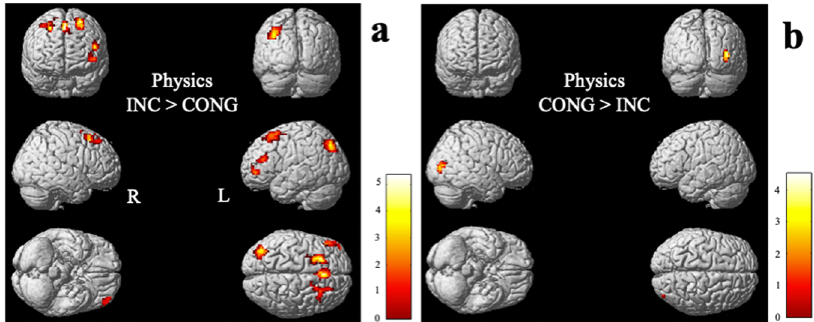
Fig. 4 Activation clusters for t-contrasts in physics. a Incongruent statements > congruent statement; b congruent statements > incongruent statement. Clusters are presented at p UNCORRECTED < 0.005 and are depicted in the standard single ‐ subject volume ‐ rendered brain implemented in SPM8. L left, R right.